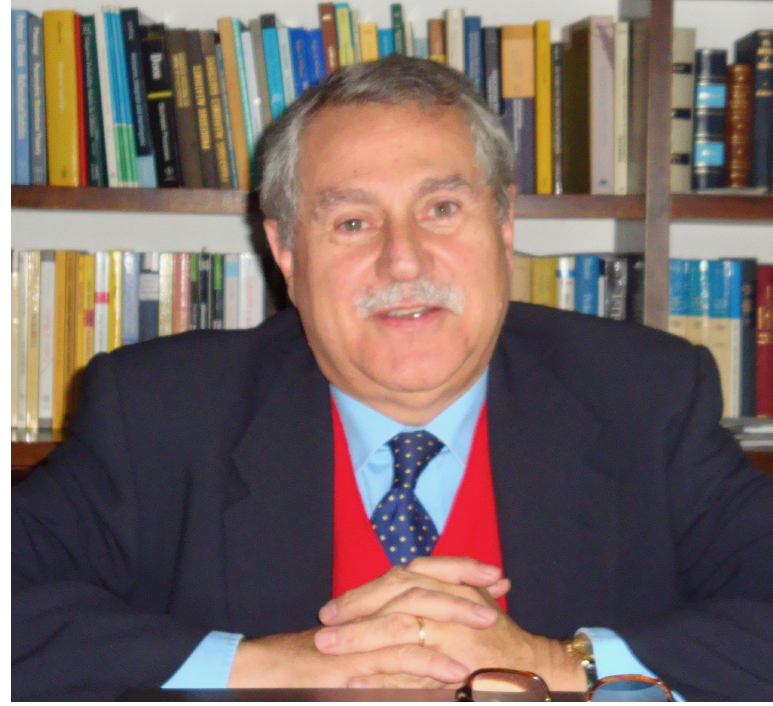
Figure 3: Dean Sempi in 2008, with a portion of his large book